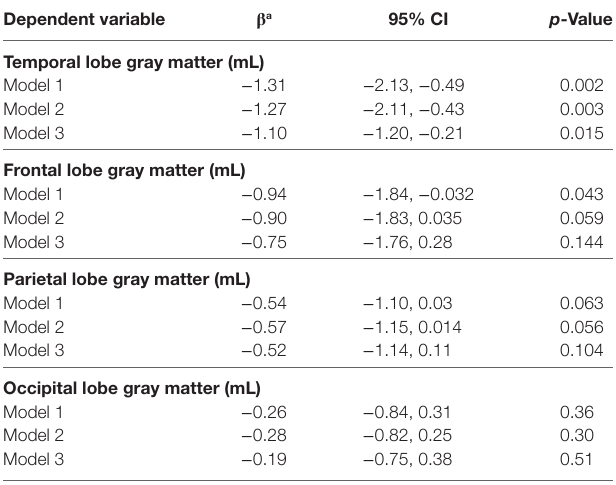
TaBle 3 | Log(NT-proBNP) and lobar gray matter volume in the CARDIA brain magnetic resonance imaging sample. Dependent variable β